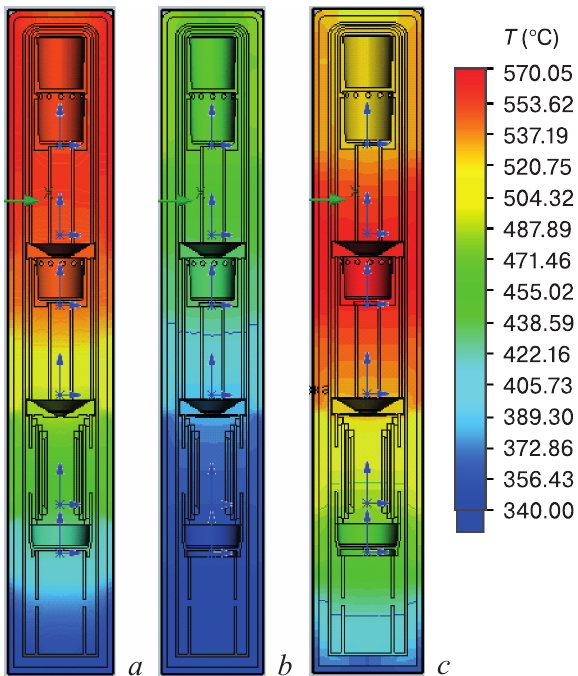
Figure 2. Simulated thermal field distribution along reactor with fittings: ( a ) filtration, ( b ) first distillation and ( c ) first